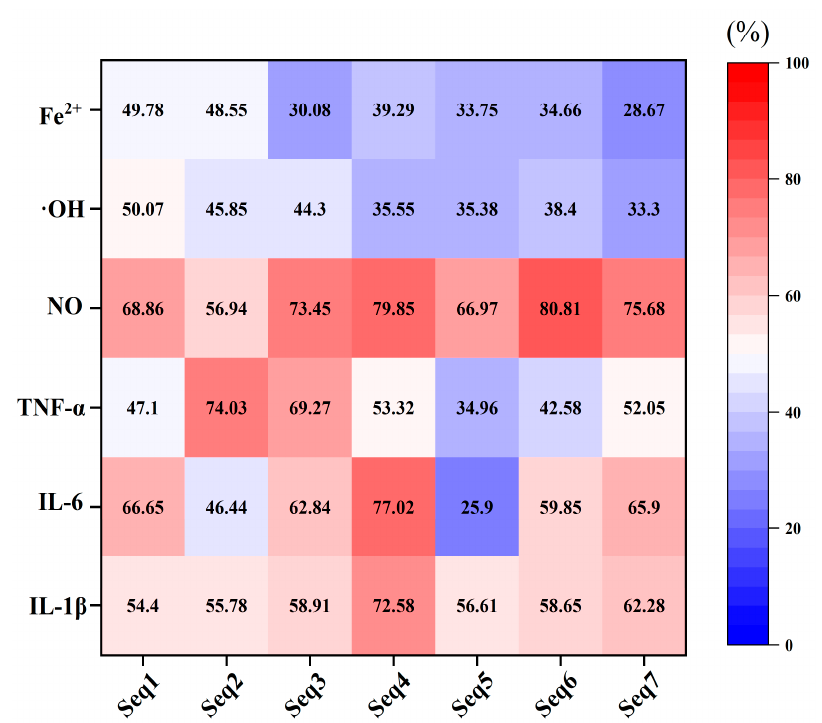
Figure 5. The anti-inflammatory and antioxidant activity in vitro test. Seq1, GGGPGPM; Seq2, GPPGPAGPAG; Seq3, FGFDGDF; Seq4, GPAGPAGPIGPVG; Seq5, AGPAGPAGPAGPR; Seq6, PGPMGPSGPR; Seq7, PAGPAGPIGPV; NO, nitric oxide; TNF- α , tumor necrosis factor- α ; IL-6, in- terleukin 6; IL-1 β , interleukin-1 beta; ·OH, hydroxyl radical; Fe2+, ferric ion. The number in each grid presents the mean value of the inhibition rates of inflammatory factors or the antioxidant ac- tivity.